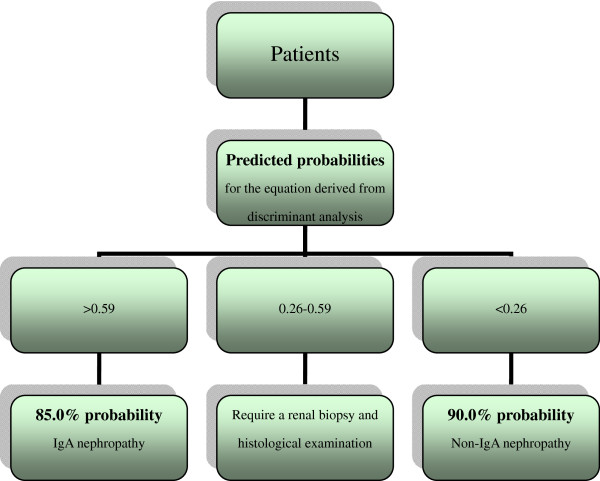
Decision procedure for the diagnosis of immunoglobulin A (IgA) and non-IgA nephropathy in patients with suspected kidney disease.